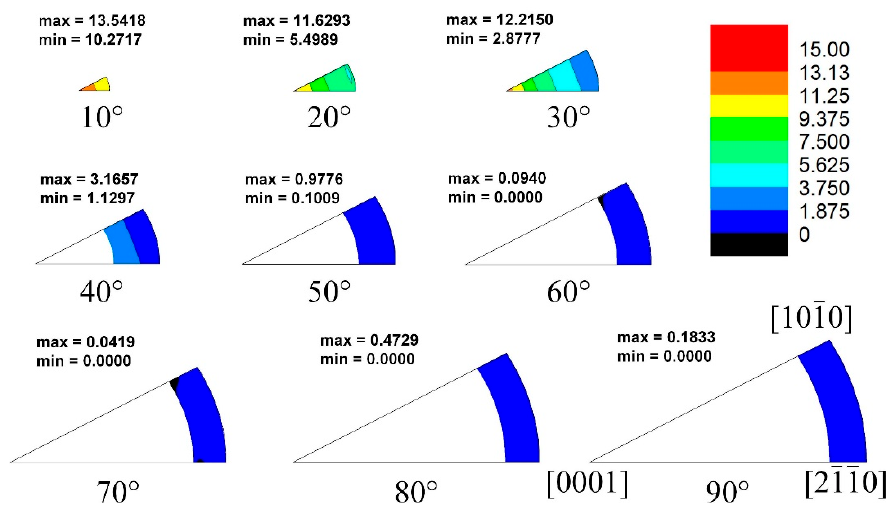
Figure 13. Misorientation distribution map of rolled AZ31 alloy.